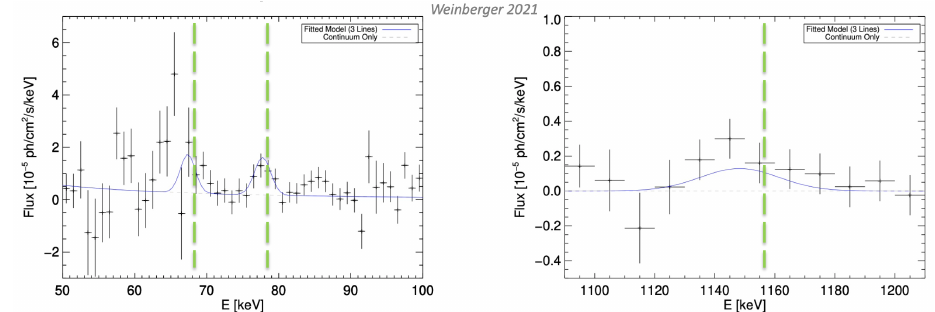
Figure 4. The signal in all lines from 44 Ti in Cas A show a bulk redshift (dashed lines mark the laboratory values of the respective line energies. [From